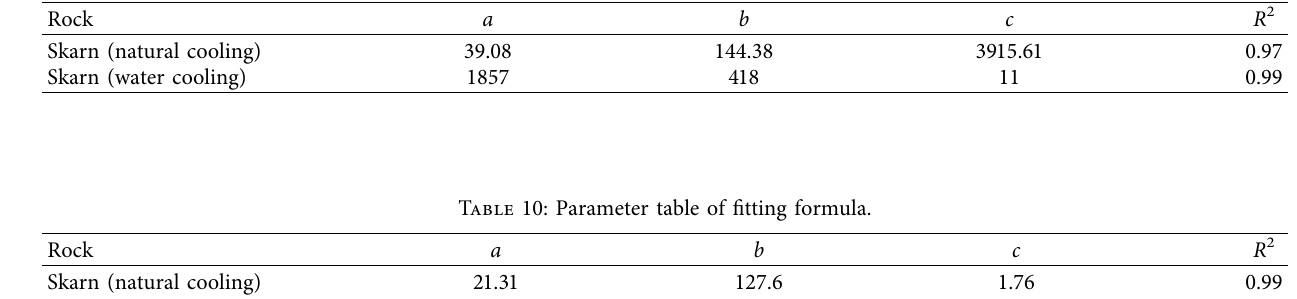
Table 9: Fitting formula parameter table (natural cooling and water cooling).